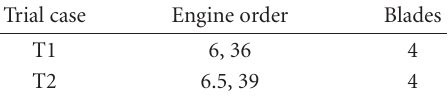
Table 1: Test cases using simulated data.